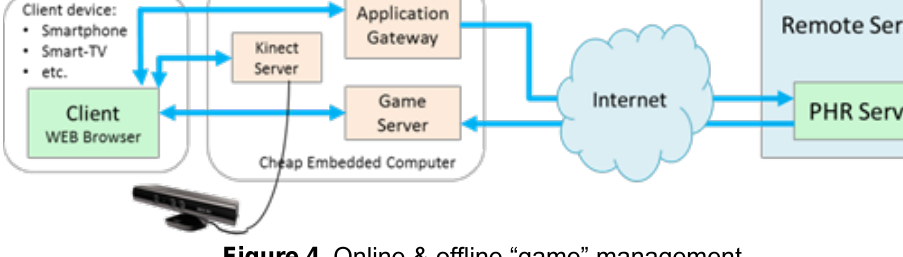
Figure 4 . Online & offline “game”